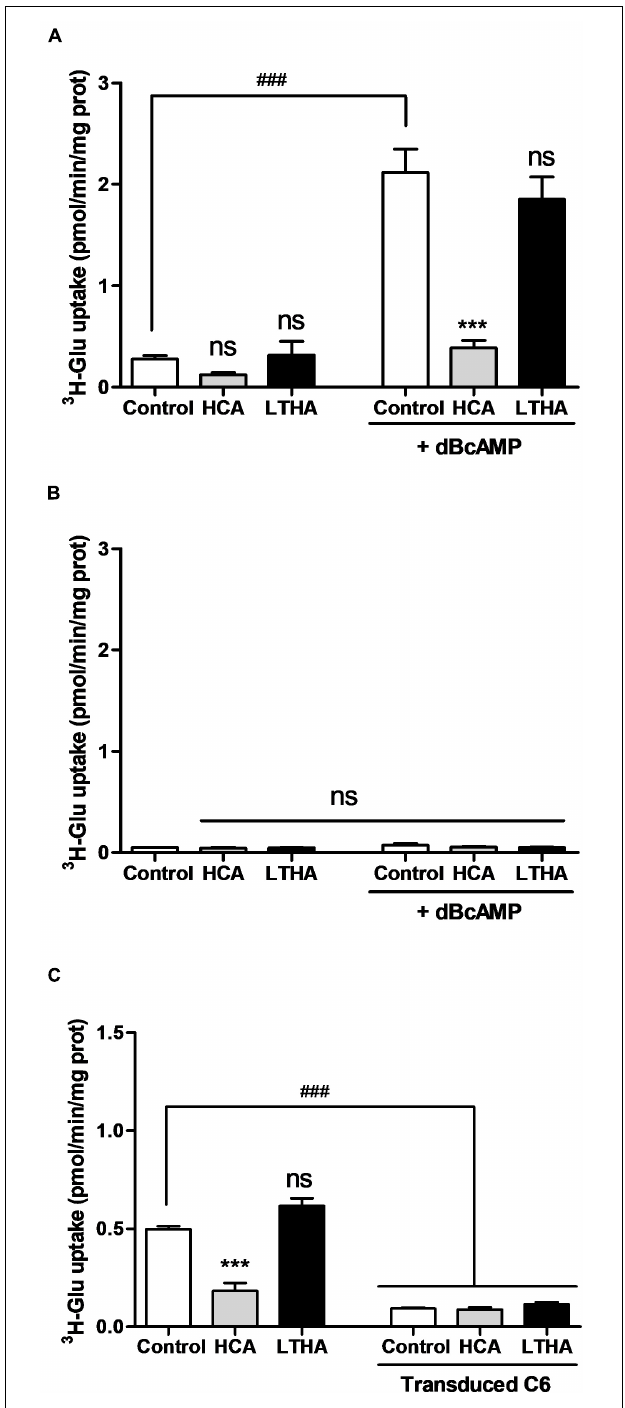
FIGURE 2 | Influence of genetic xCT deletion on [ 3 H]- L -glutamate uptake supported by system x c − in cultured astrocytes and C6 astrocytoma cells. [ 3 H]- L -glutamate uptake was quantified in primary cultured astrocytes derived from wild-type (A) or xCT − / − mice (B) maturated for 7 days in the presence or the absence of dBcAMP, as well as on C6 astrocytoma cells with and without CRISPR/Cas9-mediated xCT deletion (C) . Specific pharmacological inhibitors were used (10 − 4 M) and added to the radioactive preparation when indicated. (Continued)